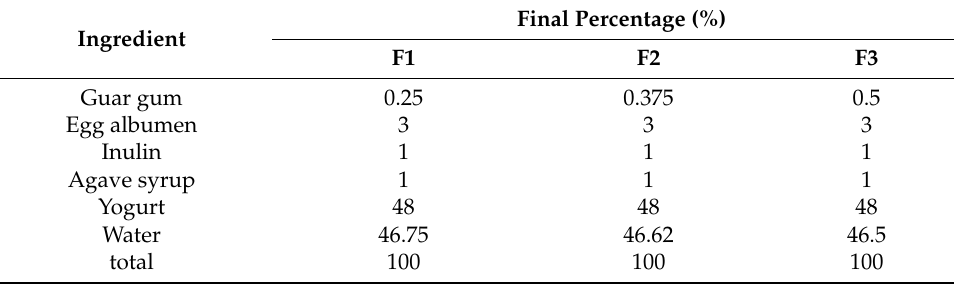
Table 1. Ingredients of each formula for the development of the